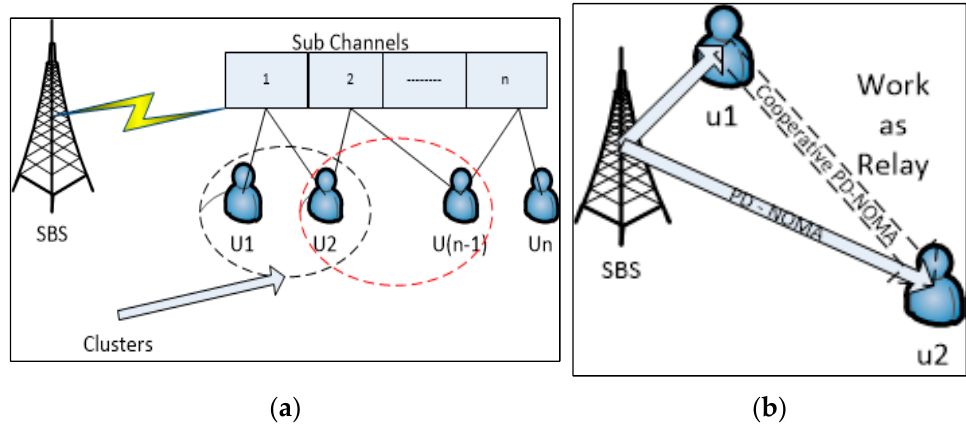
Figure 4. ( a ) Clustered PD-NOMA, ( b ) direct PD-NOMA, and cooperative PD-NOMA within the clusters.